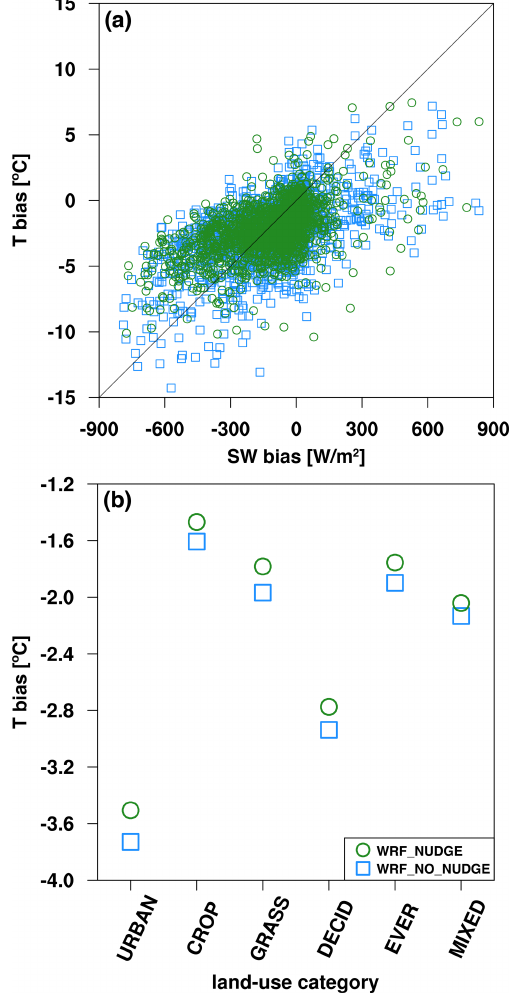
Figure 6. Scatter plots of (a) air temperature bias vs. incoming shortwave radiation bias and (b) air temperature bias vs. land use category in closest grid cell to the station. The category abbrevi- ations from left to right describe “Urban and Built-Up Land” (10 sites), “Dryland Cropland and Pasture” (4 sites), “Grassland” (72 sites), “Deciduous Broadleaf Forest” (1 site), ’Evergreen Needle- leaf Forest’ (11 sites), and “Mixed Forest” (3 sites). For both panels, data from WRF_NO_NUDGE and WRF_NUDGE are displayed as blue square and green circle markers, respectively.